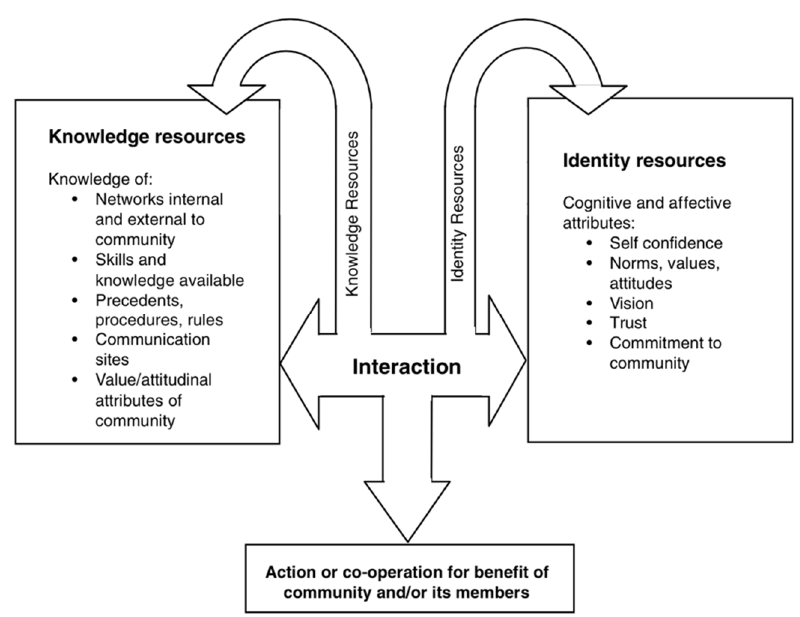
Figure 1. Simultaneous building and using of social capital. Figure from Falk and Kilpatrick, p. 101, reproduced with permission.